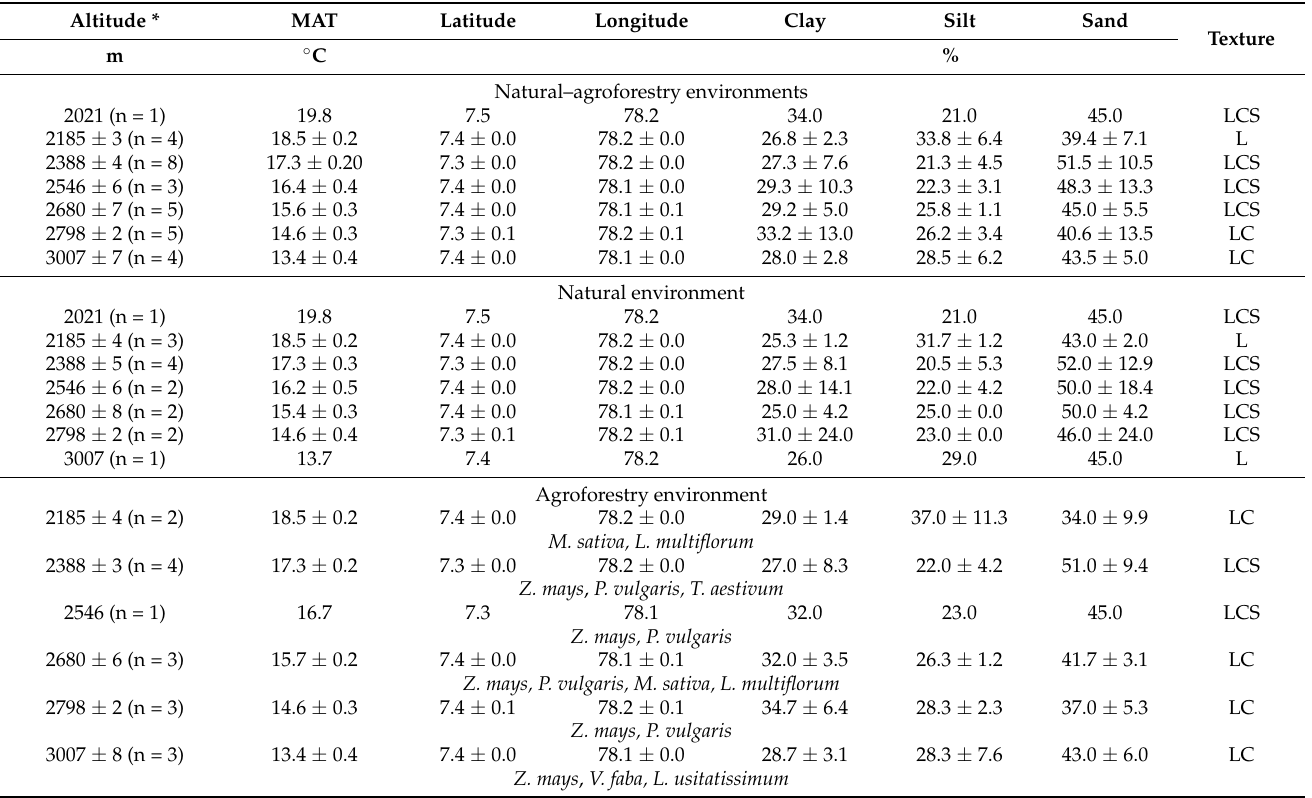
Table 2. Geographic location and soil physical properties of plots in altitude classes, in all